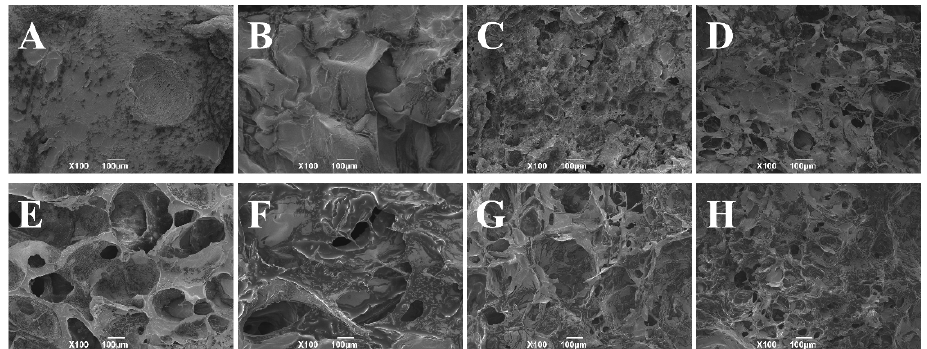
Figure 6. SEM images of konjac emulgel-based fat analogue (KGFA) with different ethanol content before and after freeze-thaw treatment. ( A , E ): 0% ethanol; ( B , F ): 2% ethanol; ( C , G ): 6% ethanol; ( D , H ): 8% ethanol.